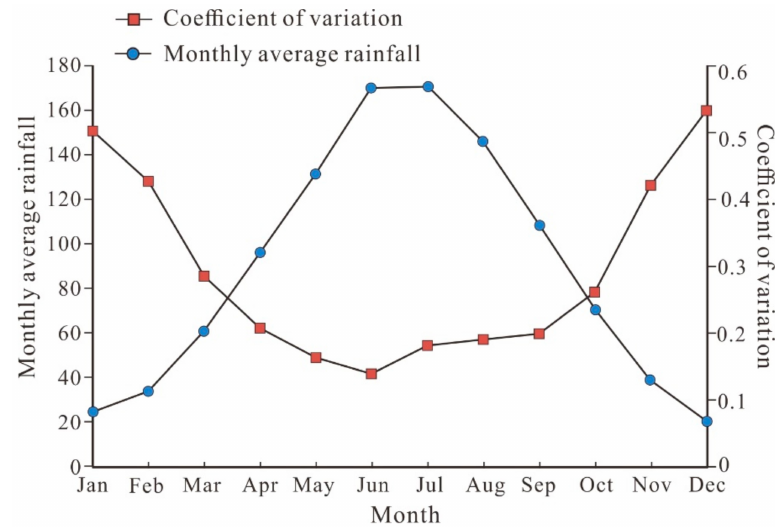
Figure 4. Monthly average rainfall and its coefficient of variation in the YRB.